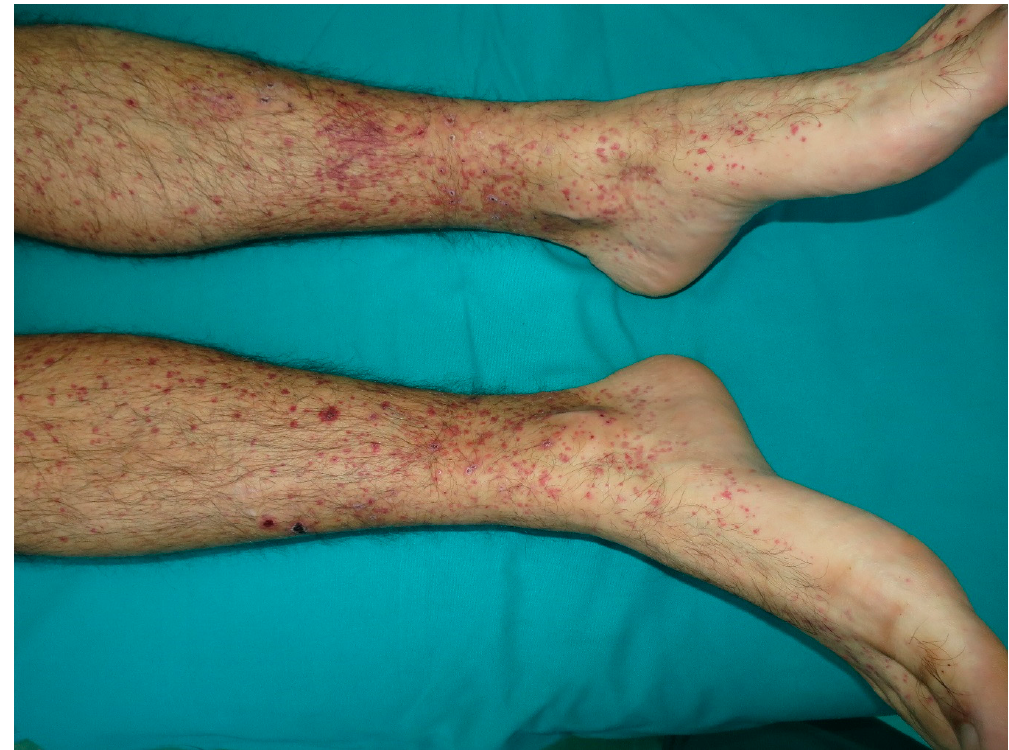
Figure 8. Vasculitis. Palpable purpuric papules on the lower extremities.